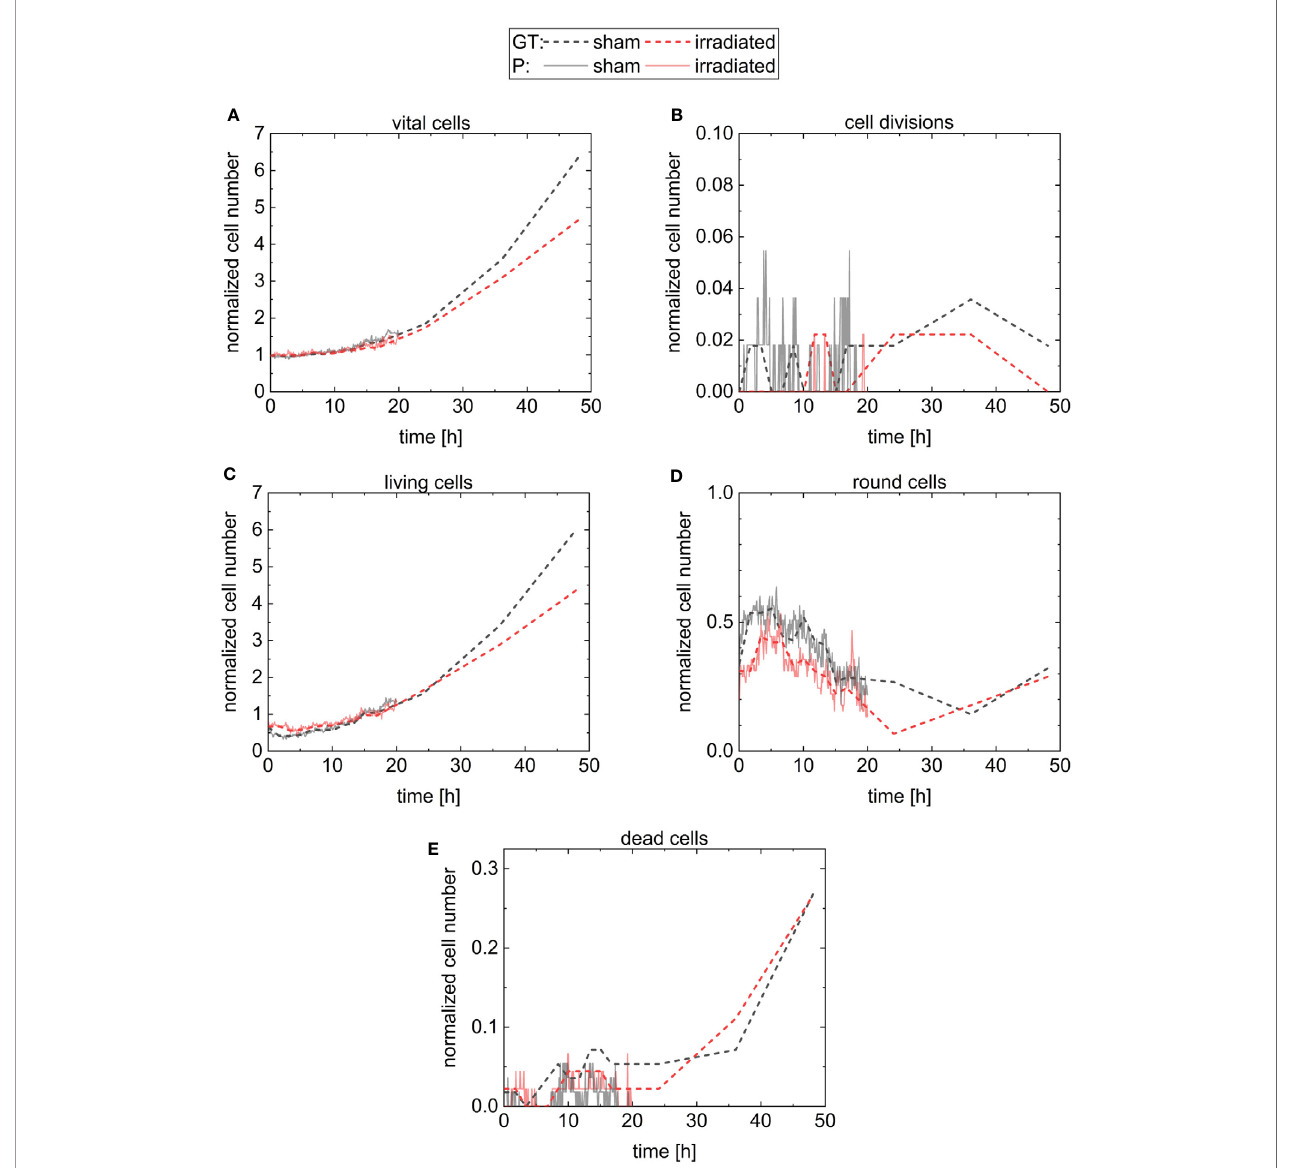
FIGURE 7 | Results for the normalized cell number of the different classes. The number of cells is normalized by the number of cells on the fi rst frame. The classes are vital cells (A) containing cells from the three classes cell divisions (B) , living cells (C) , round cells (D) , and the last class is dead cells (E) . The results for the sham sample and the irradiated sample are visualized in black and in red, respectively. The predictions of CeCILE (P) are shown by continuous lines for 20 h and the ground truth (GT) by dashed lines for 48